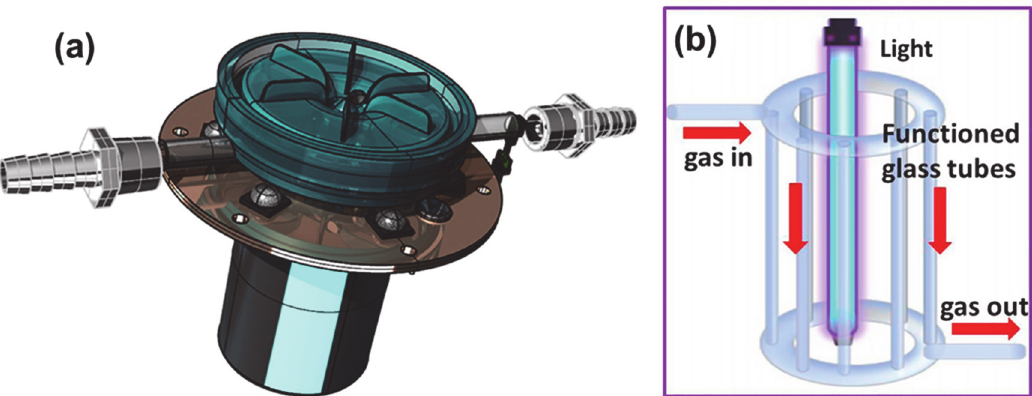
Figure 8. ( a ) 3D rendering of the reaction chamber with the fan and the LED source. (Re